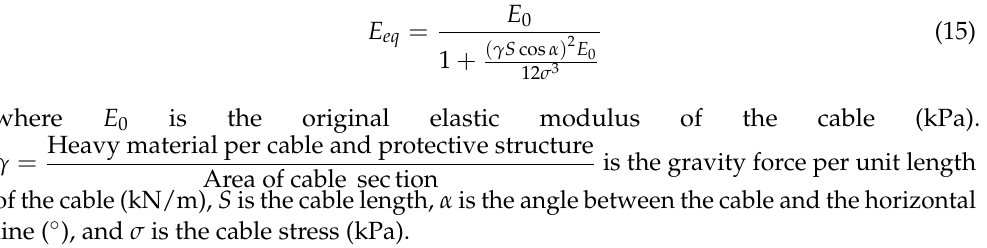
Figure 9. Standard finite element model of Nanxi River Bridge.